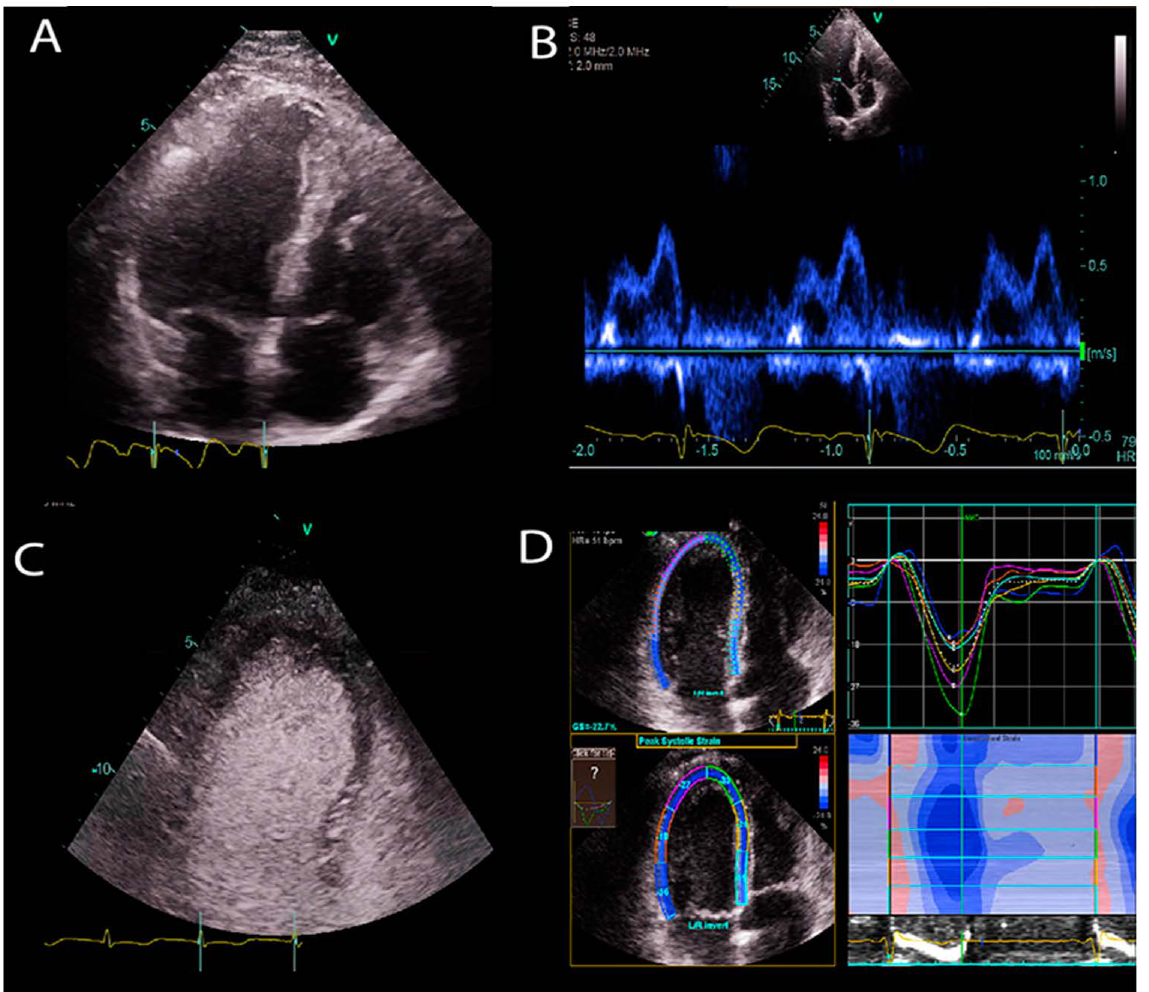
Figure 1. Sample US images showing different US modes. ( A ) B-mode image of the apical 4 chamber view of a heart. ( B ) Doppler image of mitral inflow. ( C ) Contrast enhanced ultrasound image of left ventricle. ( D ) Strain imaging of the left